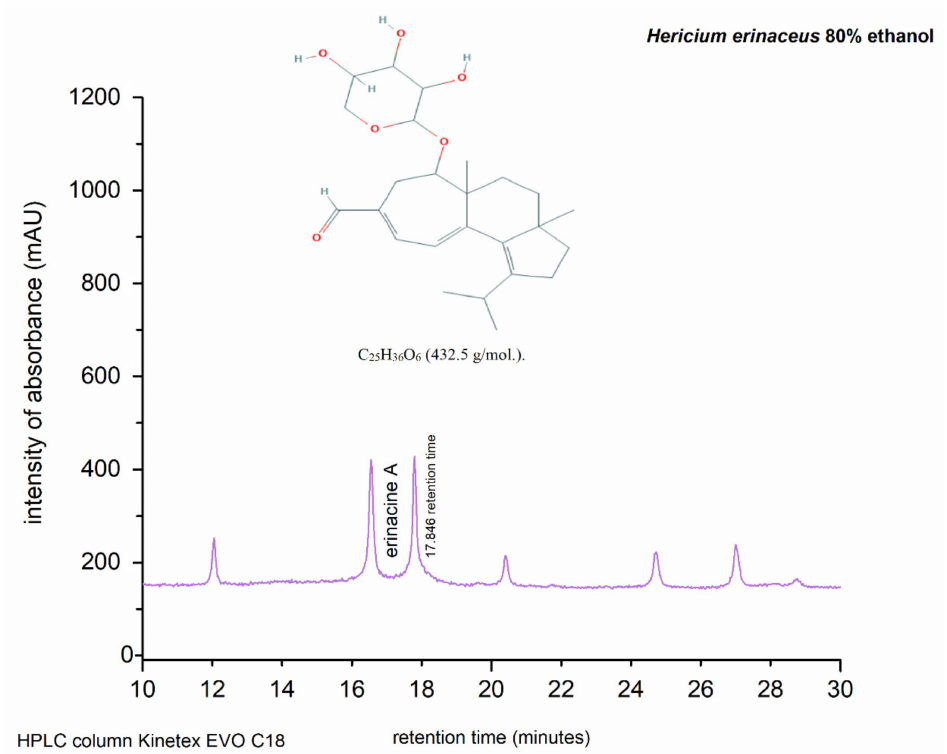
Figure 4. The HPLC sample chromatogram of erinacine A (obtained from H. erinaceus mycelium powder extract). The retention time of the diterpenoid erinacine A peak was within the range of 17.846–17.852